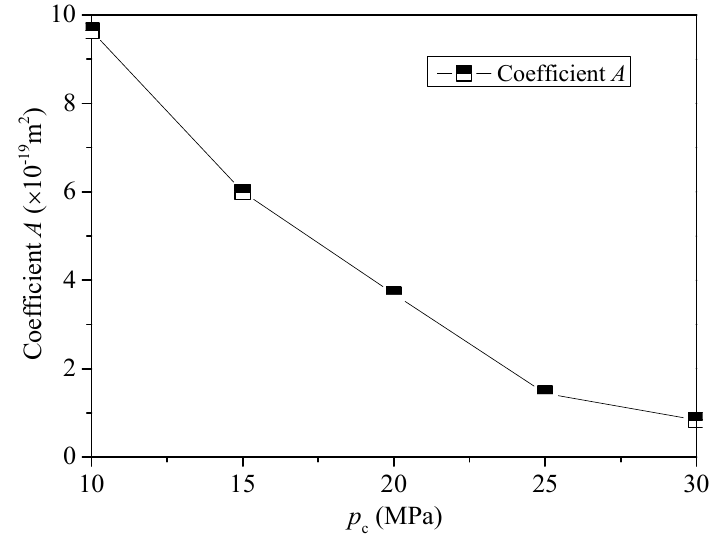
Figure 9. Variations in coefficient A with the confining pressure.